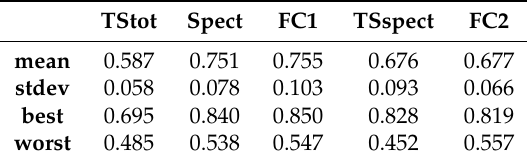
Table A5. Accuracy for narrowband excitation (52kHz to 48kHz). Compare also Figure